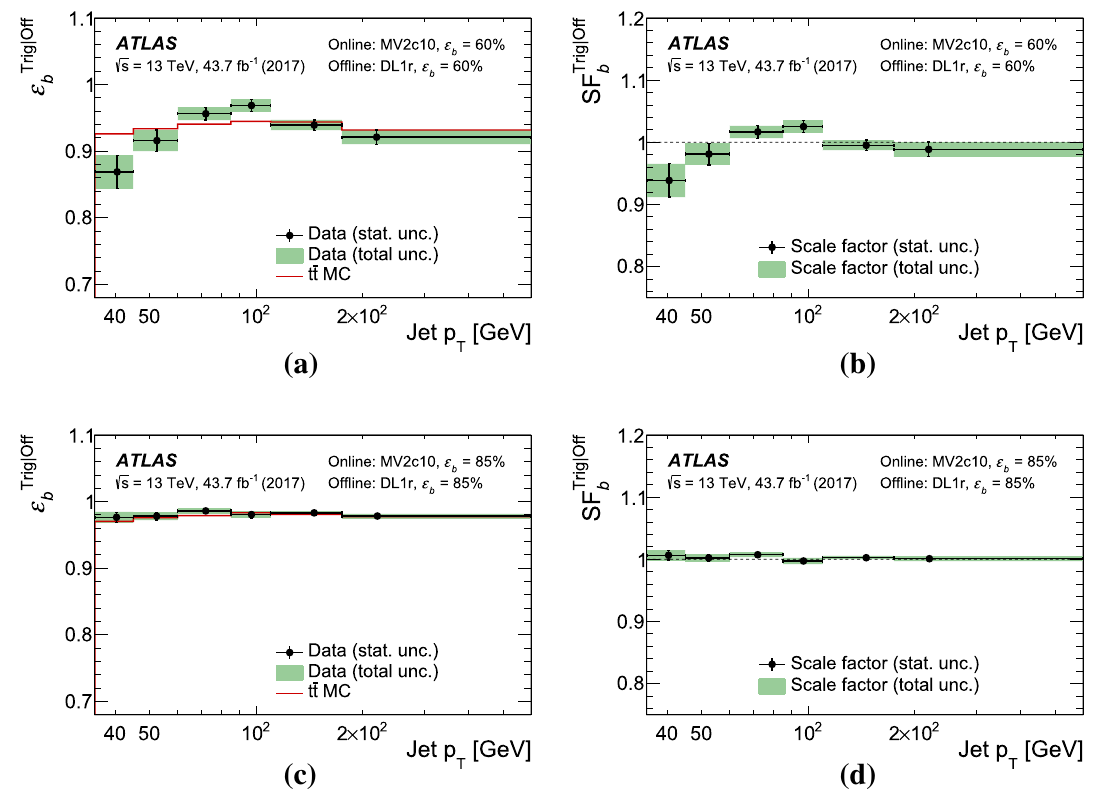
| Off Fig. 13 The conditional b -tagging efficiency, ε Trig to pass the same efficiency working points as the online jets, but using , ( a , c ) and cor- b | Off the DL1r b -tagging algorithm. Vertical error bars include data statisti- , ( b , d ) for the online MV2c10 algo- responding scale factor, SF Trig b cal uncertainties only, whereas the full band corresponds to the sum in rithmforthe60%efficiencyworkingpoint( a , b )andthe85%efficiency quadrature of all working point ( c , d ) as measured in 2017 data. Offline jets are required